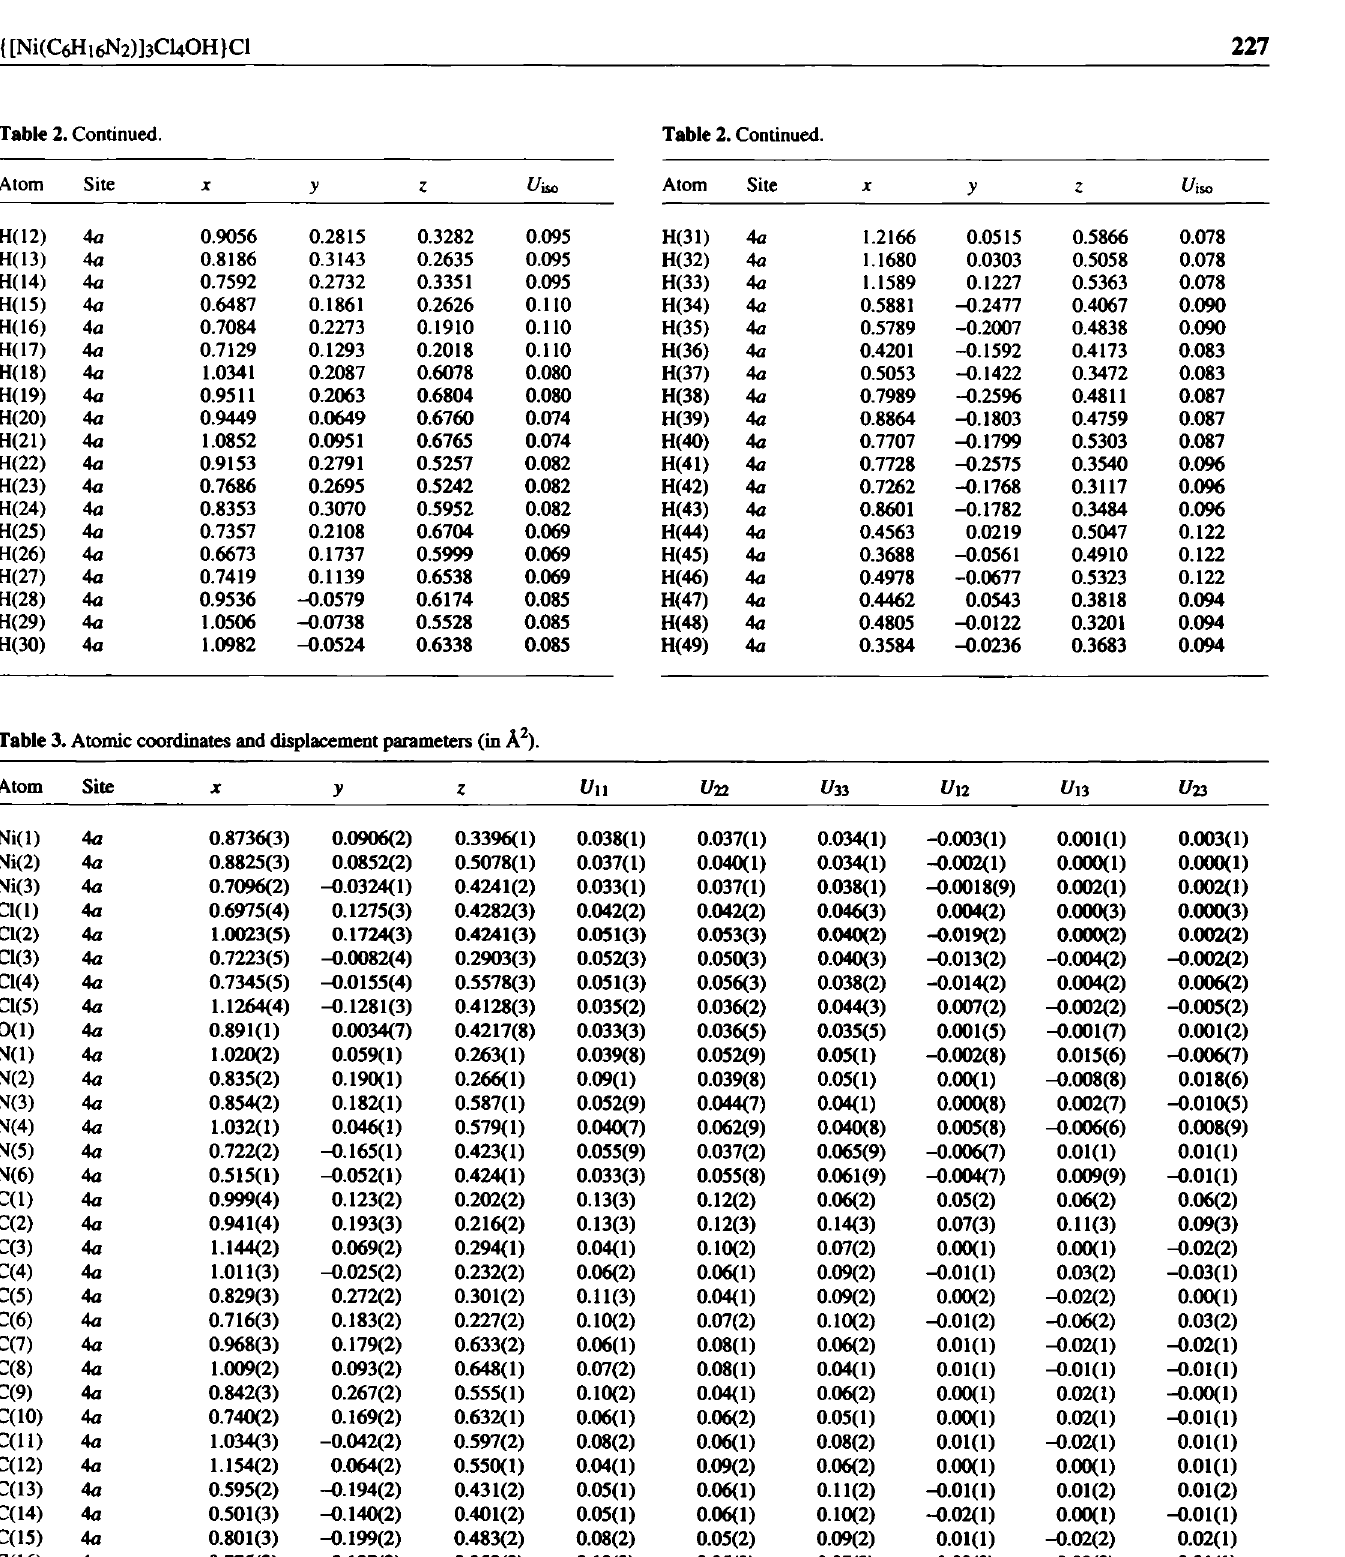
Table 3. Atomic coordinates and displacement parameters (in A 2